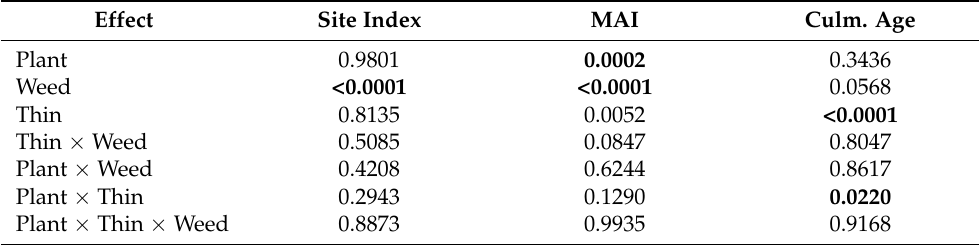
Table 6. Projected productivity variables: significance probabilities ( Prob > F values) of treatment